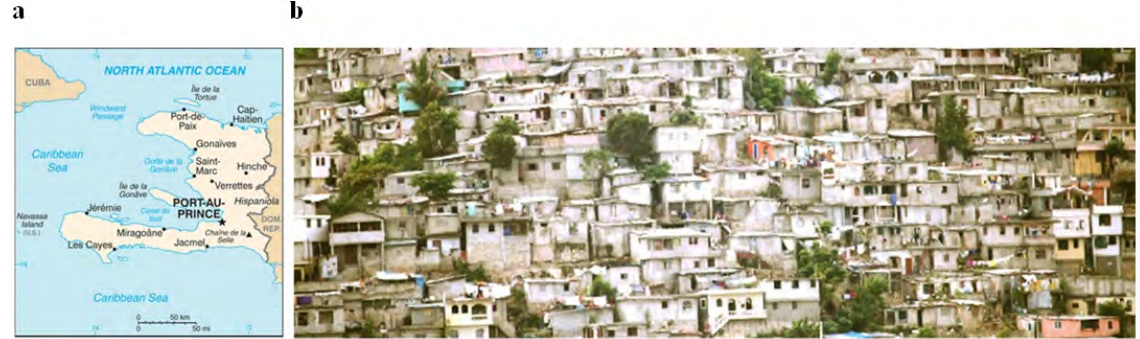
Figure 2. (a) Port-au- Prince Map. Figure 2, (b) The dense urbanization of Carrefour-Feuilles. Source: Port-au-Prince,